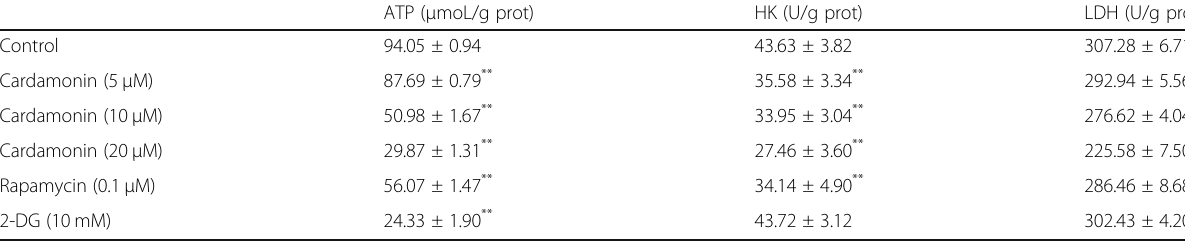
Table 1 Cardamonin inhibited ATP production and the activity of HK and LDH